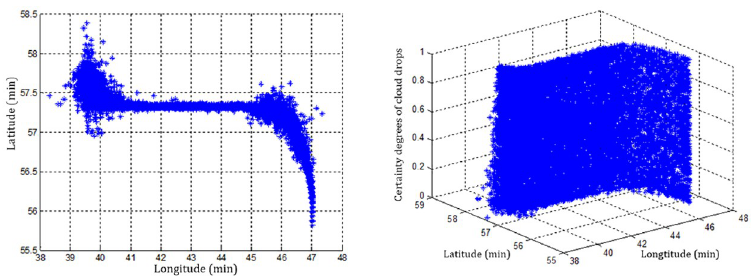
Fig 7. The normal cloud group diagram of all sampling points in the